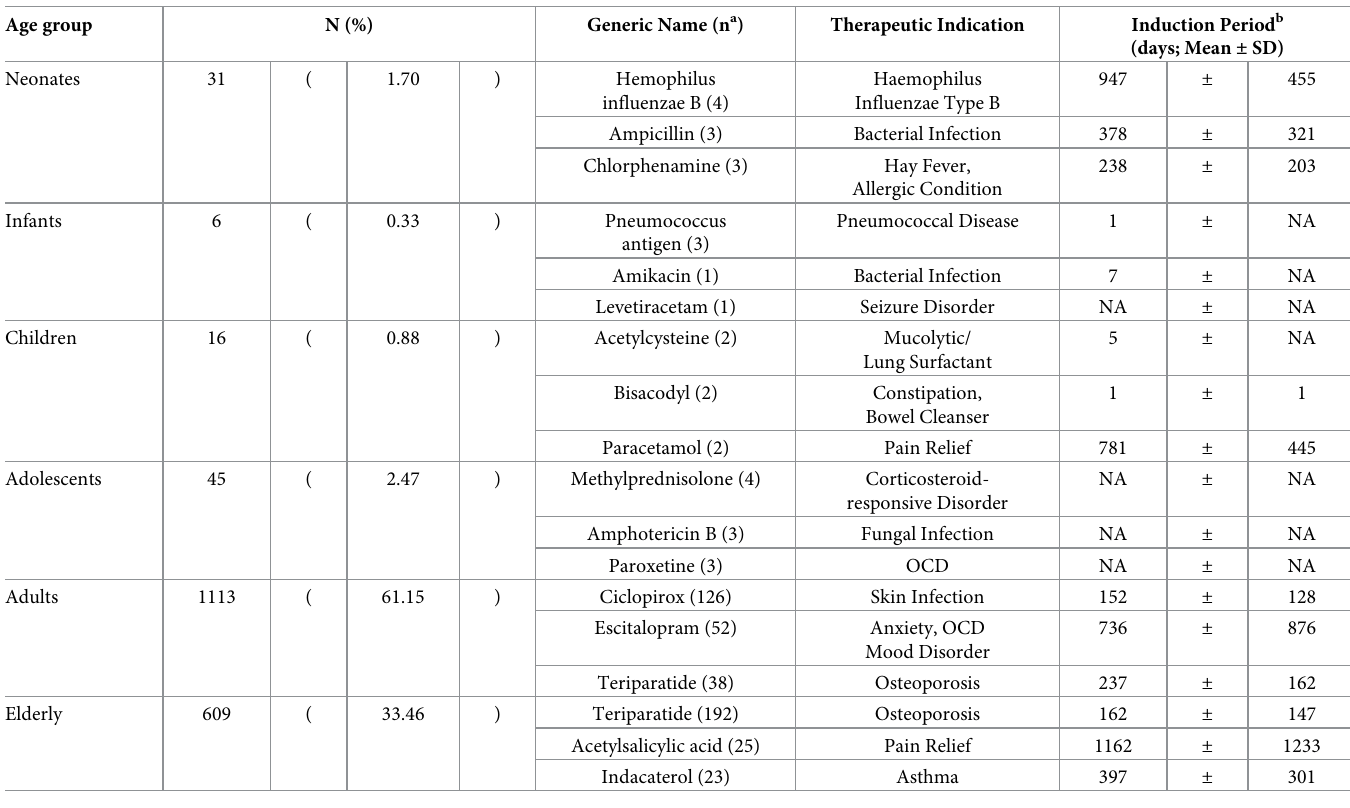
Table 3. Frequency of therapeutic ineffectiveness reports received by the KAERS in 2016 and the three most frequently reported generic name according to the matched age